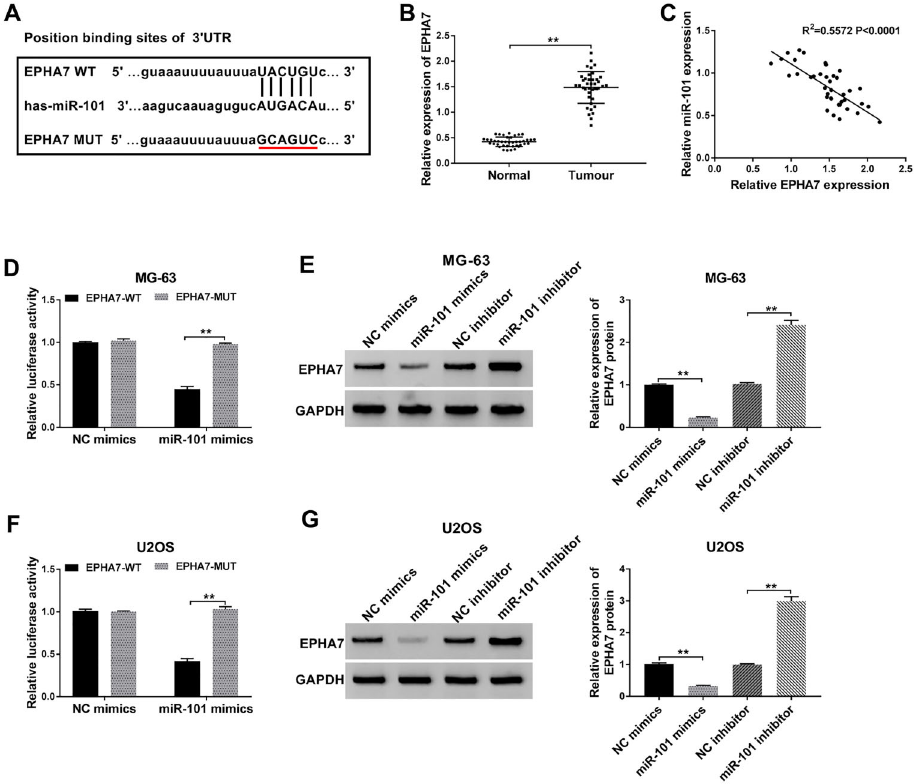
Figure 5. EPHA7 was a target of miR-101. A , Predicted binding sites between miR-101 and EPHA7 3 ’ UTR. B , The expression of EPHA7 was measured through qRT-PCR assay in osteosarcoma (OS) tissues and adjacent normal tissues. C , Correlation analysis between miR-101 expression and EPHA7 expression in OS tissues. D and F , Relative luciferase activity was measured in MG-63 and U2OS cells cotransfected with miR-101 mimics and EPHA7-WT (wild-type) or EPHA7-MUT (mutant). E and G , EPHA7 protein expression level was observed by western blot in MG-63 and U2OS cells with NC (negative control) mimics, miR-101 mimics, NC inhibitor, or miR-101 inhibitor transfection. Data are reported as means ± SD. ** P o 0.01 (Student ’ s t -test and